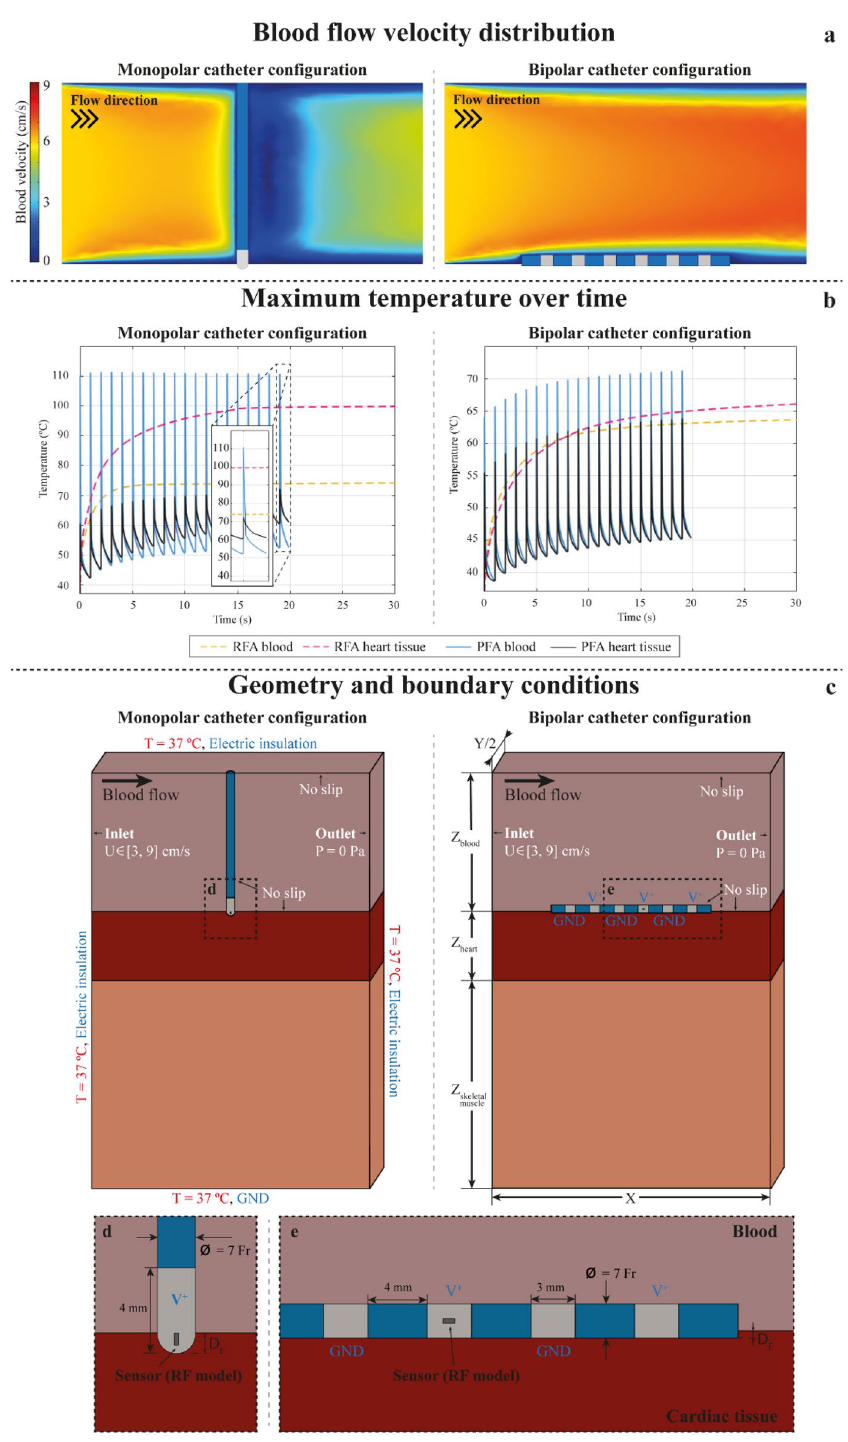
Figure 1. ( a ) Blood flow velocity distributions in ( a.left ) the monopolar catheter configuration and ( a.right ) the bipolar catheter configuration, ( b ) maximum temperature over time in ( b.left ) the monopolar catheter configuration and in ( b.right ) the bipolar catheter configuration. Maximum temperatures predicted for blood and cardiac tissue in RFA (dashed lines) and in PFA (solid lines) and ( c ) geometry and boundary conditions used for the monopolar and bipolar configurations. Electrical (blue), thermal (red) and fluid dynamics (white) boundary conditions are indicated for both catheter configurations. In ( d ) and ( e ) a magnification of the contact points is depicted for the monopolar and bipolar catheter configurations,